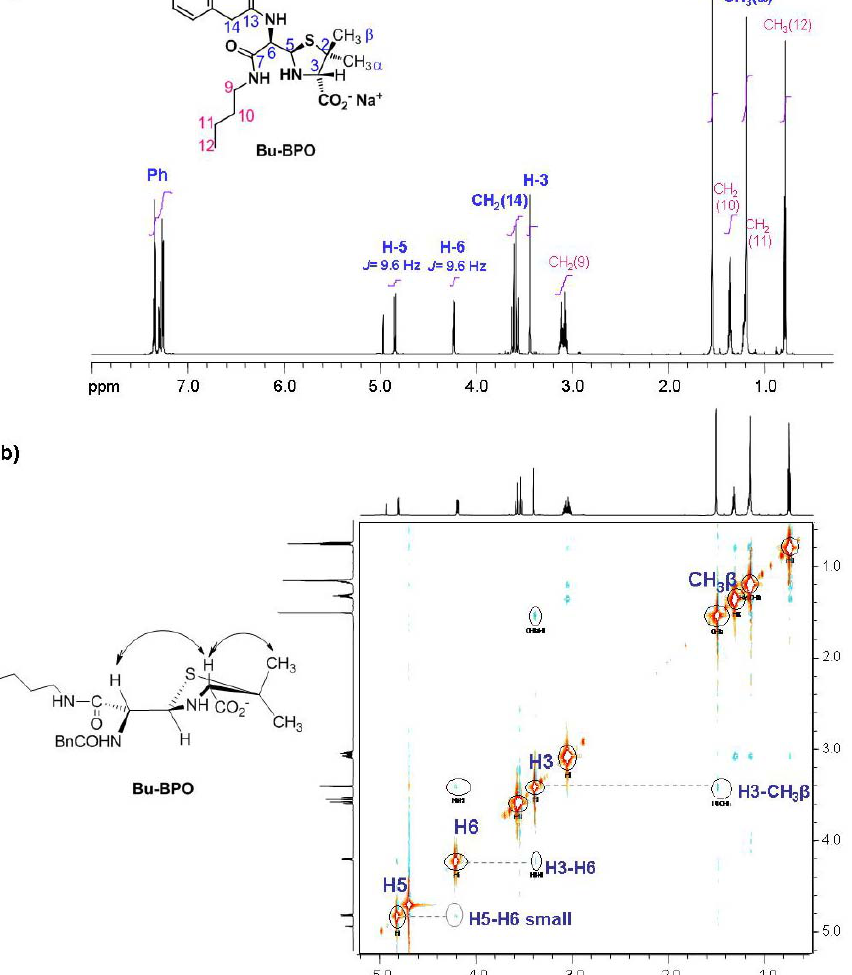
O with solvent signal suppression; 2